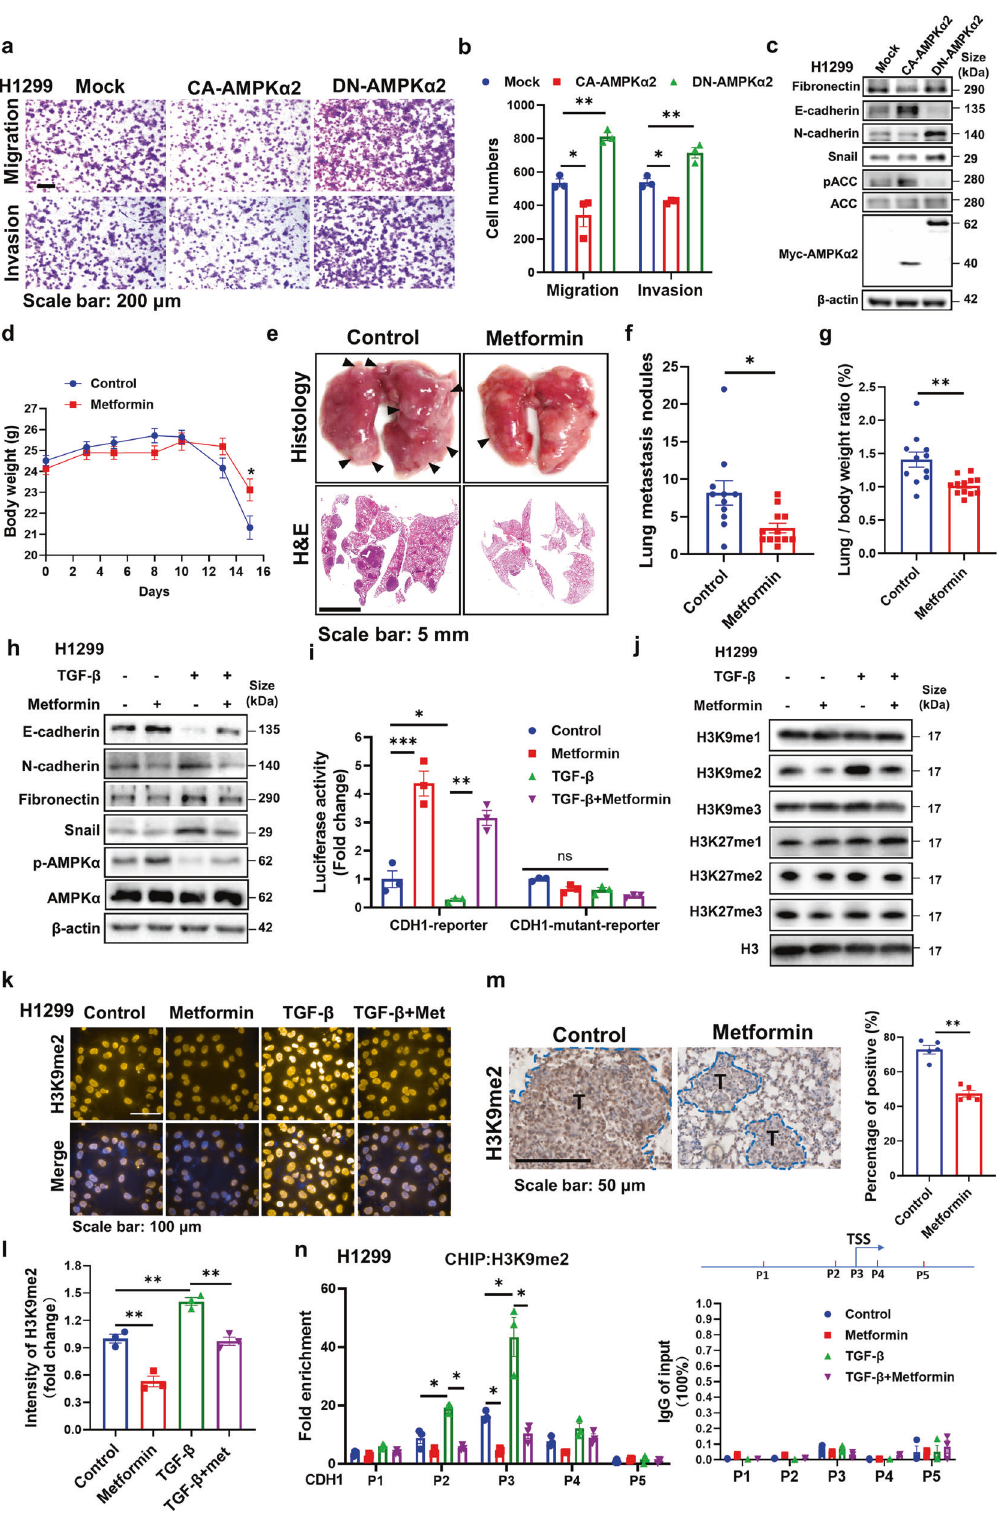
PHF2 has been reported as a tumor suppressor associated with p53 in colon cancer, 28,32,33 whereas whether it is related with lung cancer metastasis remains unknown. Thus, before further